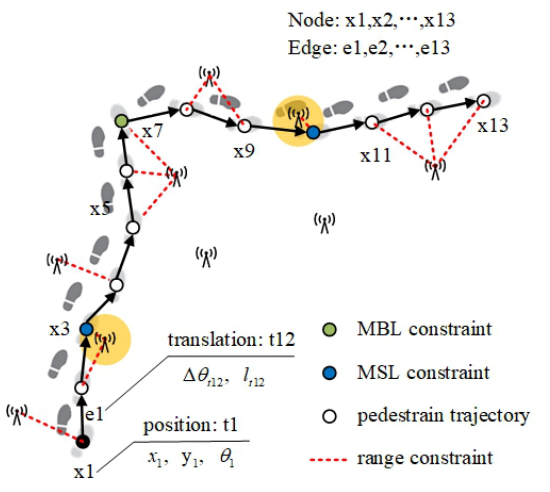
Figure 2: Illustration of the proposed graph model mainly in- cludes three constraints: MBL, MSL, and range measurement.